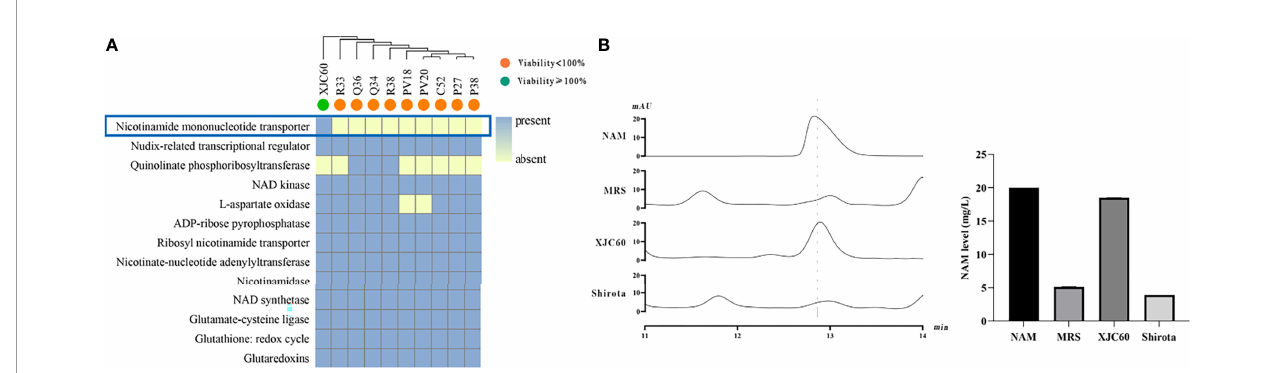
FIGURE 3 | Genomic mining and validation of the antiphotoaging metabolites of lactic acid bacteria (LAB). (A) Genes involved in the NAD, NADP, and oxidative stress pathways in different LAB strains. The antiphotoaging potential is indicated as a node, with green representing high potential and orange representing low potential. The existence of a gene is shown in the squares, with blue representing the presence of the gene and yellow representing the absence of the gene. (B) HPLC quanti fi cation of nicotinamide (NAM) levels in the minimum nontoxic dilutions (MNTDs) of different LAB strains.